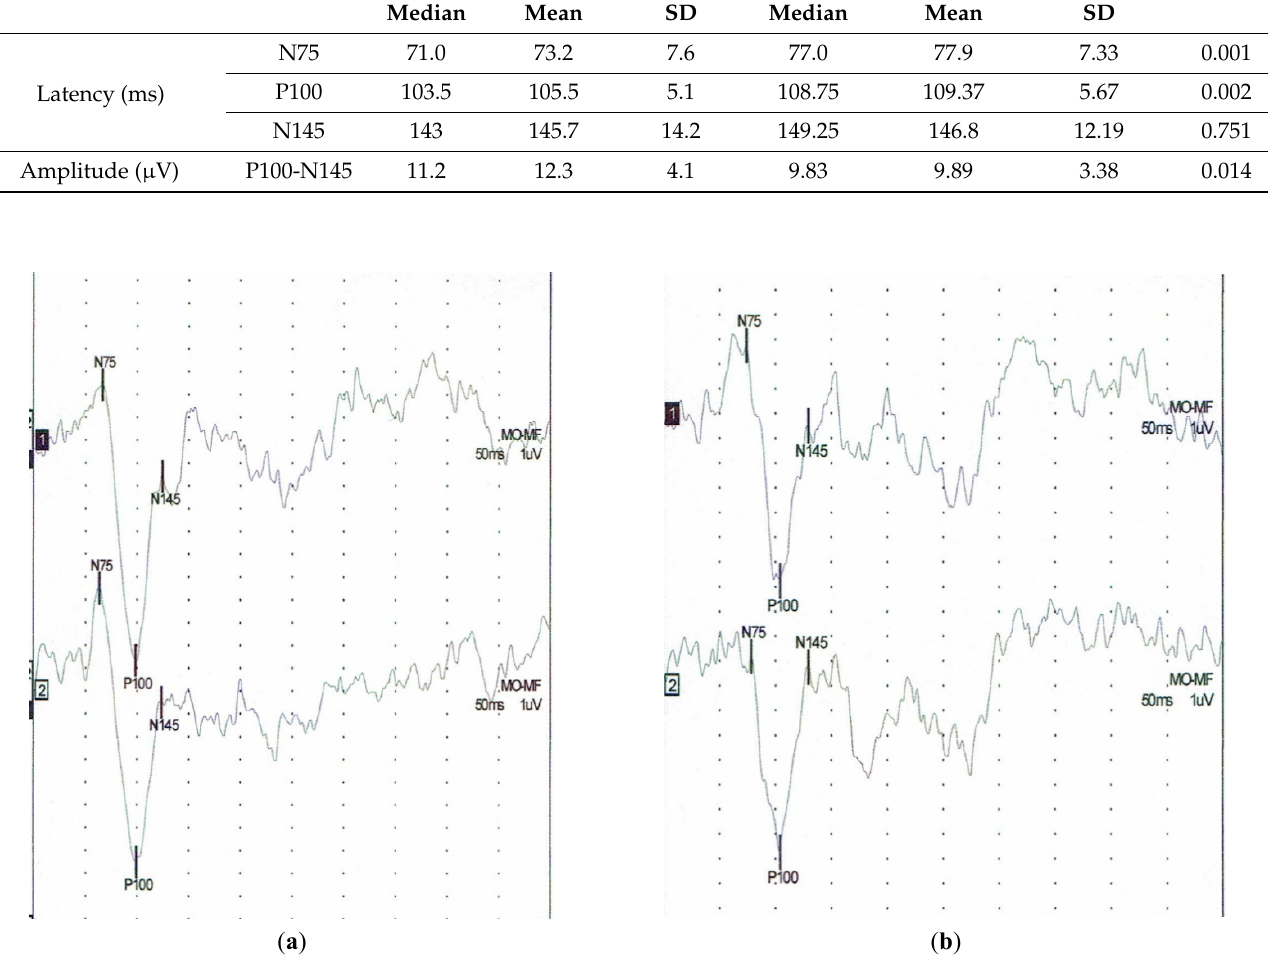
Figure 3. Example of visual evoked potentials (VEP) in the patient with pSS ( a ) baseline study latency of P100 (left side 98 ms, right side 98.5 ms), ( b ) follow up after 6 years latency of P100 (left side 104 ms, right side 104 ms). Table 3. Visual evoked potentials in the study group after 6 years.